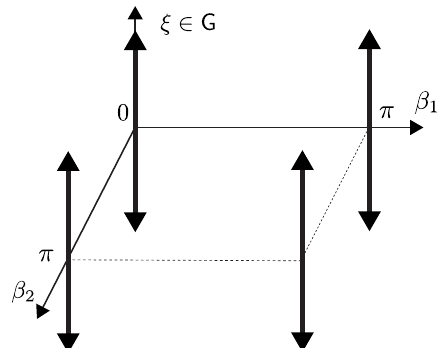
Figure 7. For two sliding constraints, the involutive closure of the coannihilator of the generalized codistribution D foliates Q into five separate leaves. The four leaves indicated by the bold rays corre- spond to the leaves at the four singular points of D . The fifth leaf fills the remaining open space